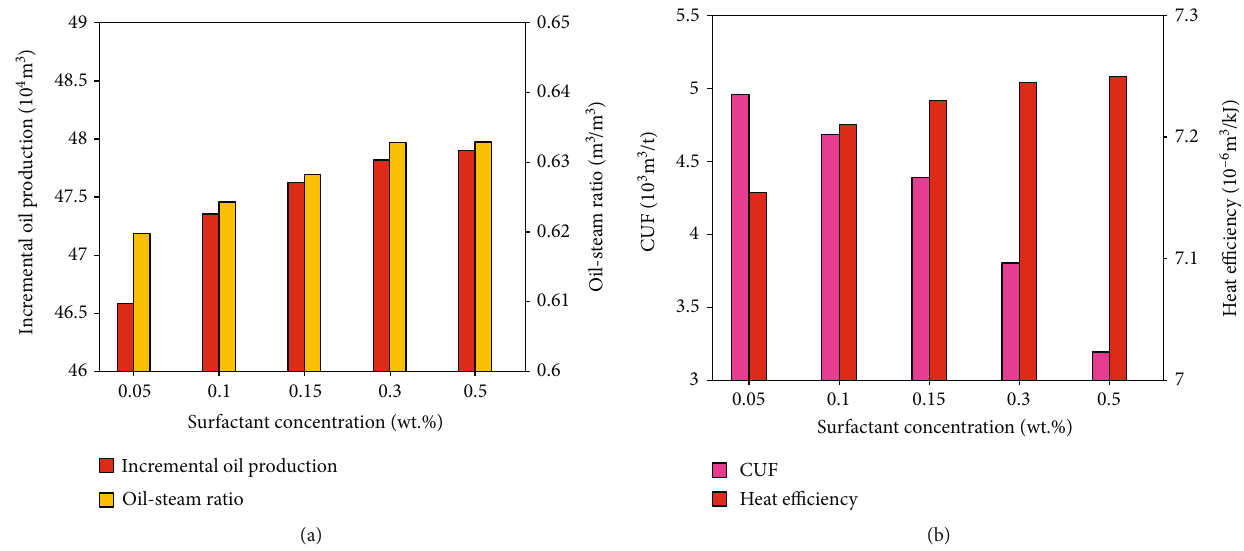
Figure 7: E ff ect of the surfactant concentration: (a) incremental oil production and oil-steam ratio; (b) CUF and heat e ffi ciency.